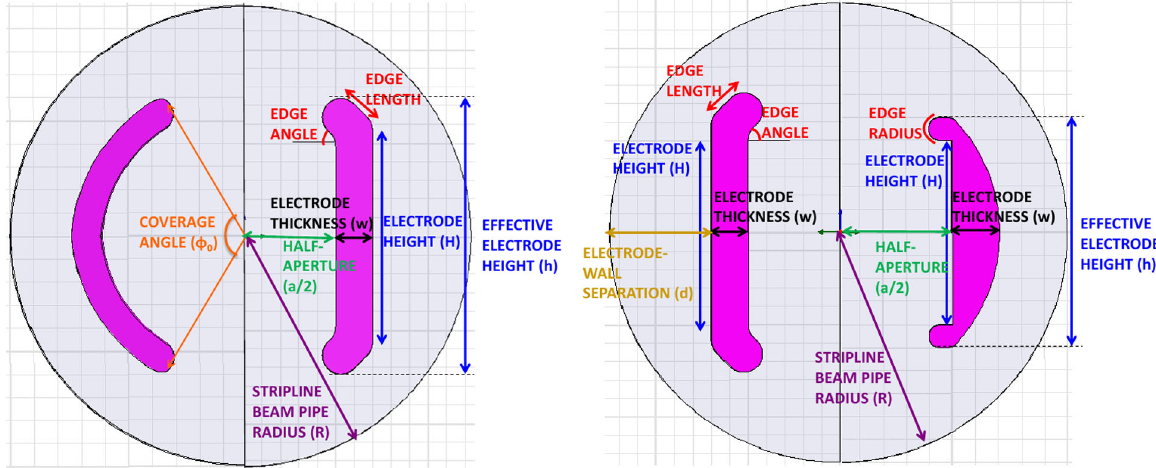
R.FIG. 5. Geometric parameters used to optimize the shape of the electrodes: the schematic on the left shows the parameters for a curved and a flat electrode, and the schematic on the right for a flat and a half-moon electrode type (e).